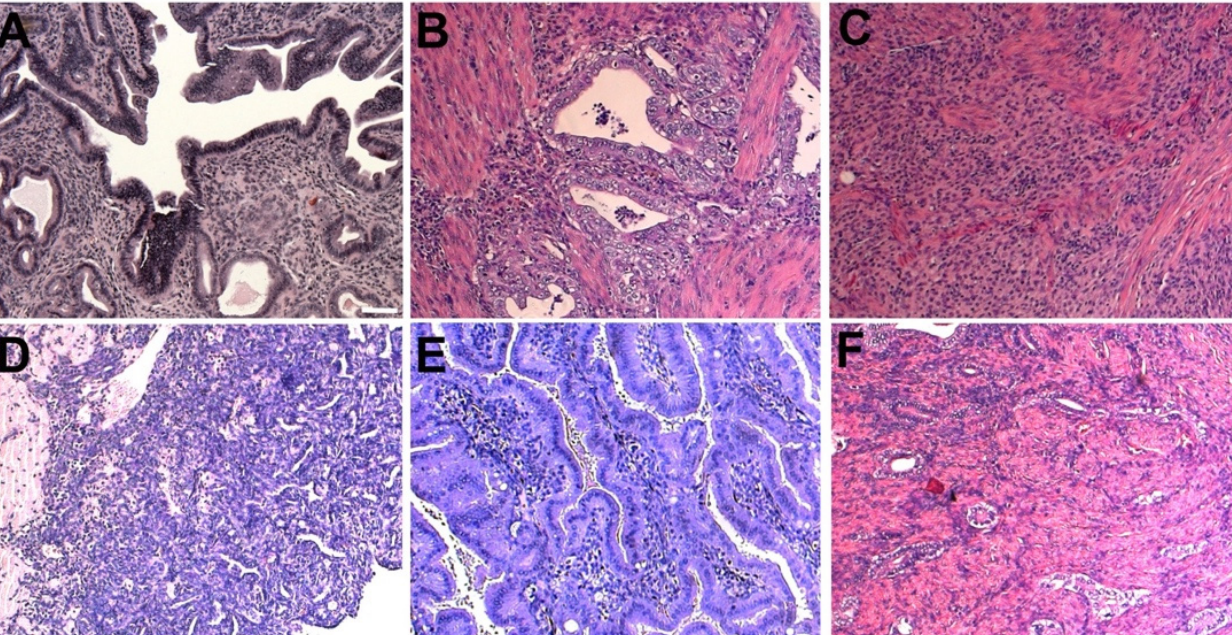
Figure 4. Gynecological malignancies developed in the p53 cohort after Ad-K8-Cre injection. ( A – C ) Representative histological images of hyperplasia ( A ), endometrial adenocarcinoma ( B ), and leiomyosarcoma ( C ) in the uterus. ( D , E ) Representative histological images of endometrioid carcinoma ( D ) and serous adenocarcinoma in the ovary ( E ) from the injected p53/Brca1 mice. ( F ) Representative histological image of atypical endometrial hyperplasia in the uterus from the injected p53/Rb1 females. Scale bar (same for all panels) = 50 μ m.